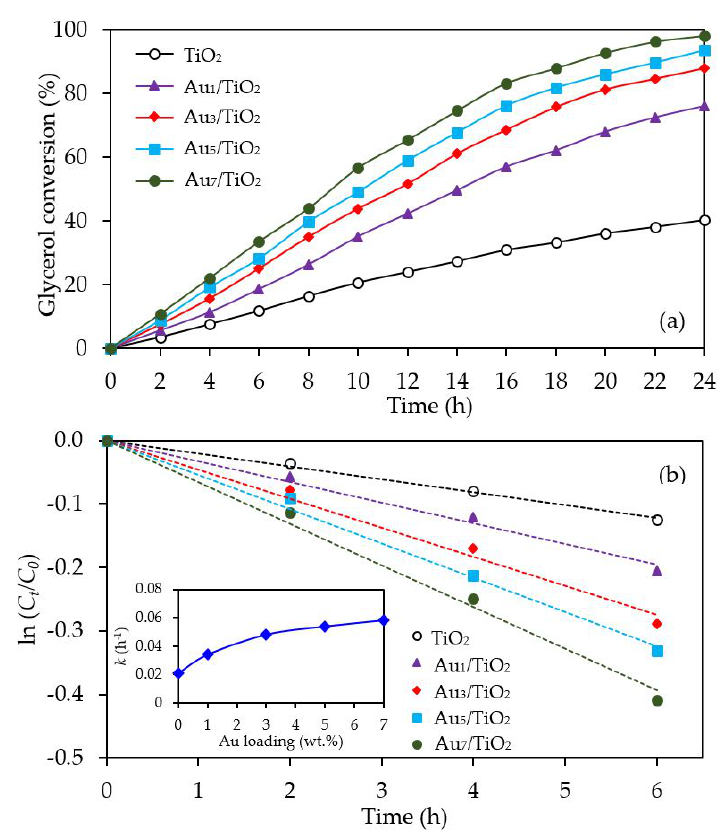
Figure 6. Representative ( a ) glycerol conversion and ( b ) plot of ln ( C t / C 0 ) as a function of time in the presence of the TiO 2 or different Au x /TiO 2 ( x = 1–7) photocatalysts at a loading of 3.0 g/L, light intensity of 4 . 7 mW / cm 2 and using O 2 as the electron acceptor.